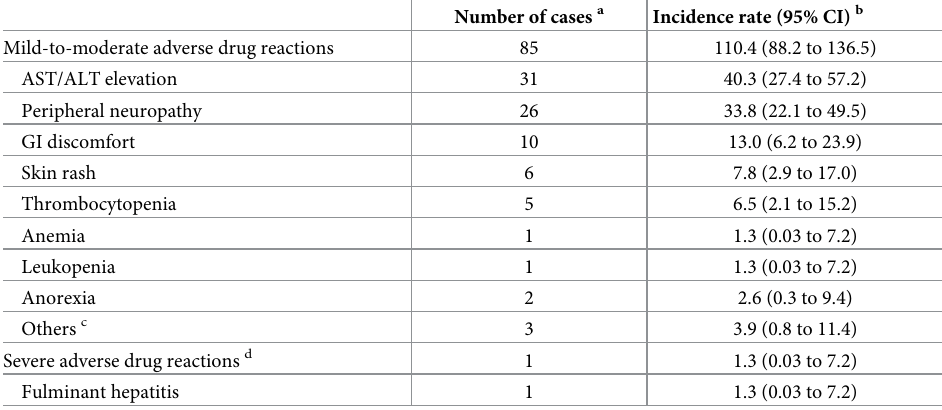
Table 4. The incidence of adverse drug reactions caused by prophylactic INH.